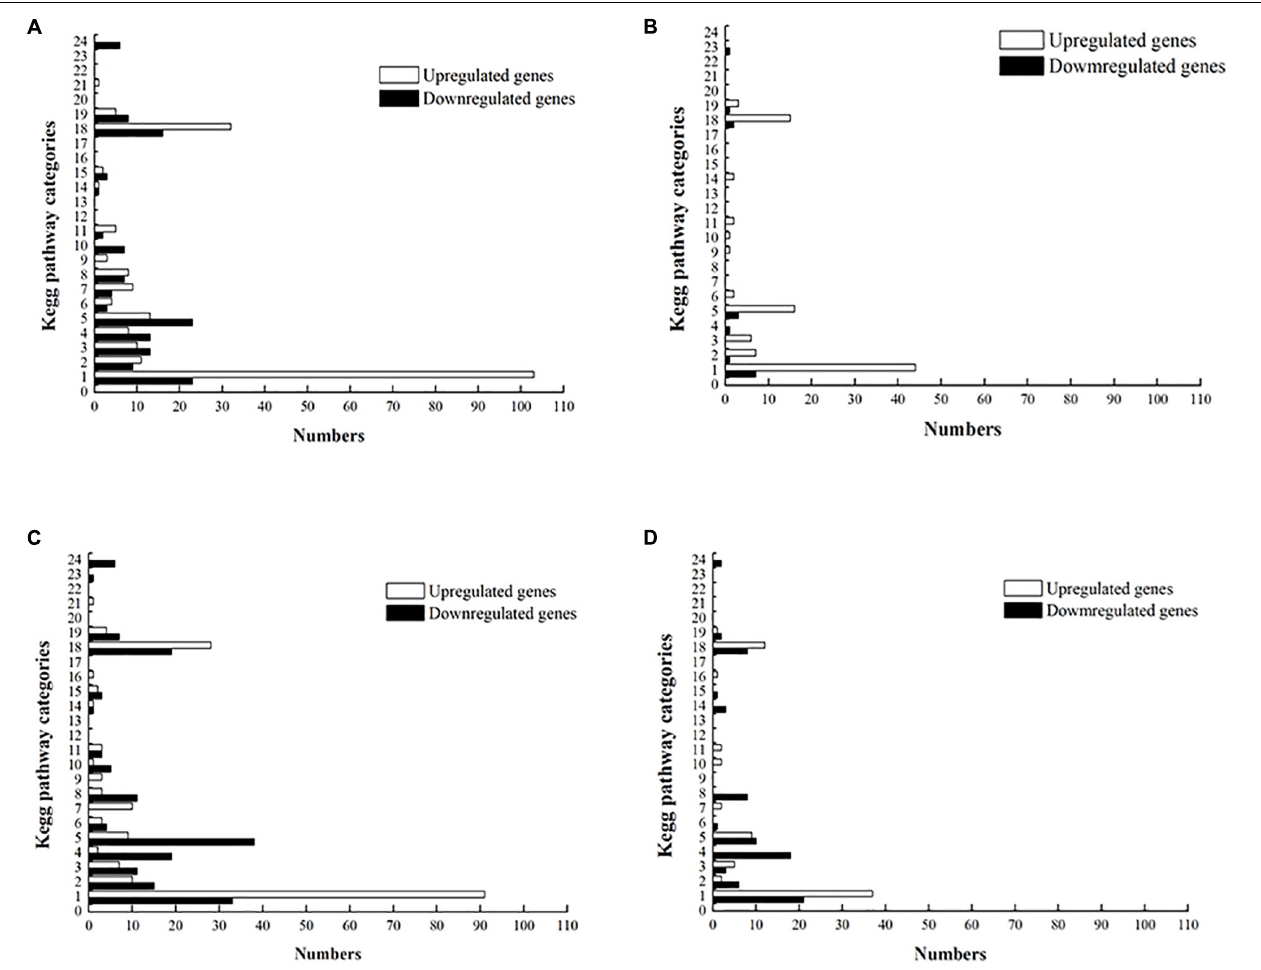
FIGURE 2 | Distribution of upregulated and downregulated genes in the four pair-wise comparisons based on KEGG pathway categories. (A) The ccpA mutant grown on glucose versus the wild-type strain grown on glucose. (B) The ccpA mutant grown on GOS versus the wild-type strain grown on GOS. (C) The wild-type strain grown on GOS versus the wild-type strain grown on glucose. (D) The ccpA mutant grown on GOS versus the ccpA mutant grown on glucose. KEGG pathway categories: 1, carbohydrate metabolism; 2, energy metabolism; 3, lipid metabolism; 4, nucleotide metabolism; 5, amino acid metabolism; 6, metabolism of other amino acids; 7, glycan biosynthesis and metabolism; 8, metabolism of cofactors and vitamins; 9, metabolism of terpenoids and polyketides; 10, biosynthesis of other secondary metabolites; 11, xenobiotic biodegradation and metabolism; 12, enzyme families; 13, transcription; 14, translation; 15, folding, sorting, and degradation; 16, replication and repair; 17, RNA family; 18, membrane transport; 19, signal transduction; 20, signaling molecules and interaction; 21, transport and catabolism; 22, cell motility; 23, cell growth and death; 24, cellular community –